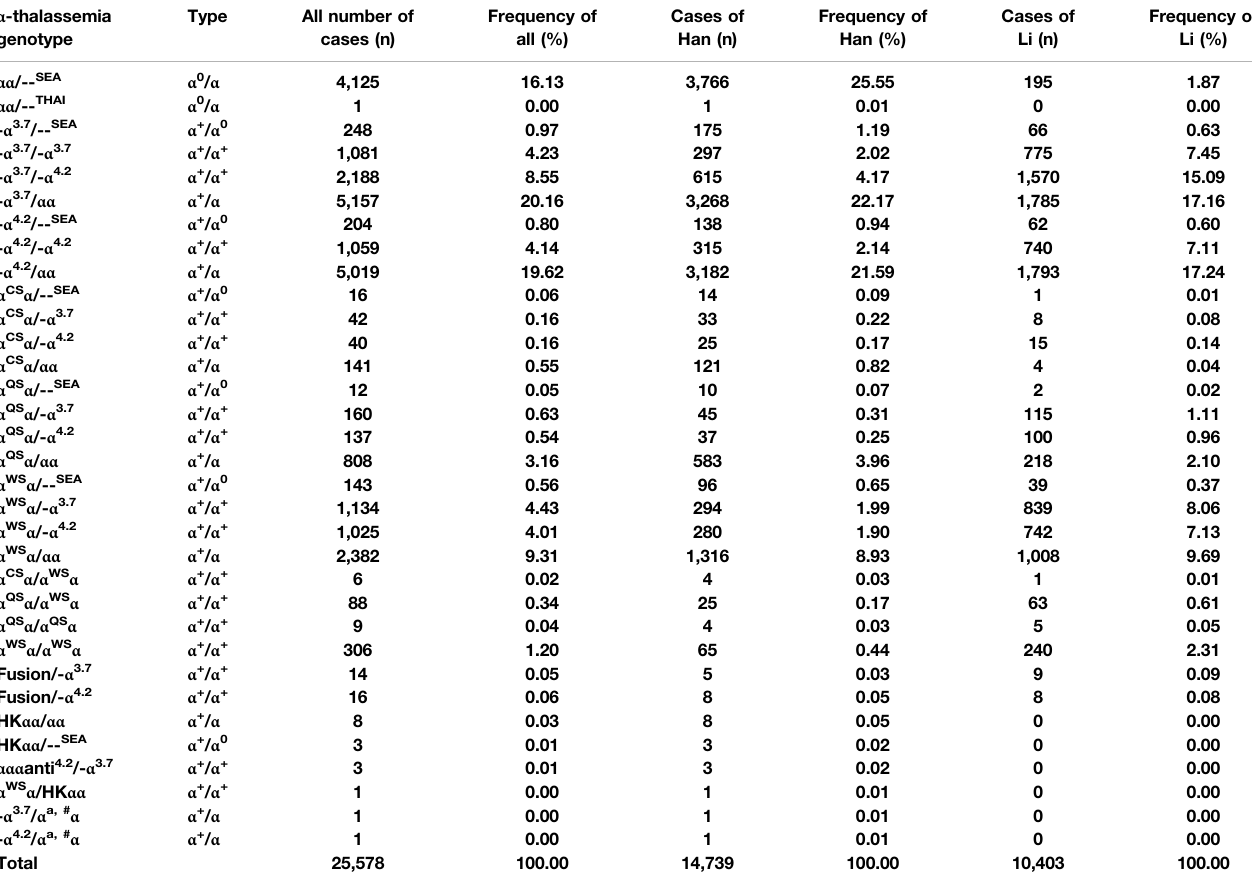
TABLE 1 | Molecular mutation spectrum of α -thalassemia in the population of childbearing age in the Hainan Island. α -thalassemia